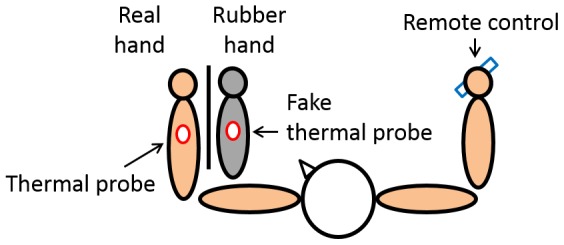
Experimental setting for pain threshold measurement.A thermal probe was placed on the participant's forearm and a fake thermal probe was placed on the forearm of the rubber hand. The participant was instructed to stare at the rubber hand during the pain threshold measurement. The experimenter increased the temperature of the stimulus by 1°C per second. The participant used a remote control in his/her right hand to stop the temperature from increasing any further the moment pain was felt. The temperature was recorded as the pain threshold.